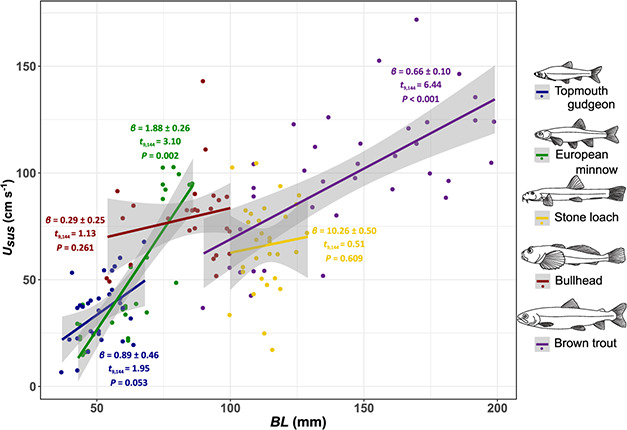
Interspecific variation in sustained swimming speed (Usus) with BL; slope estimates (β), t values and P values provided for each species.